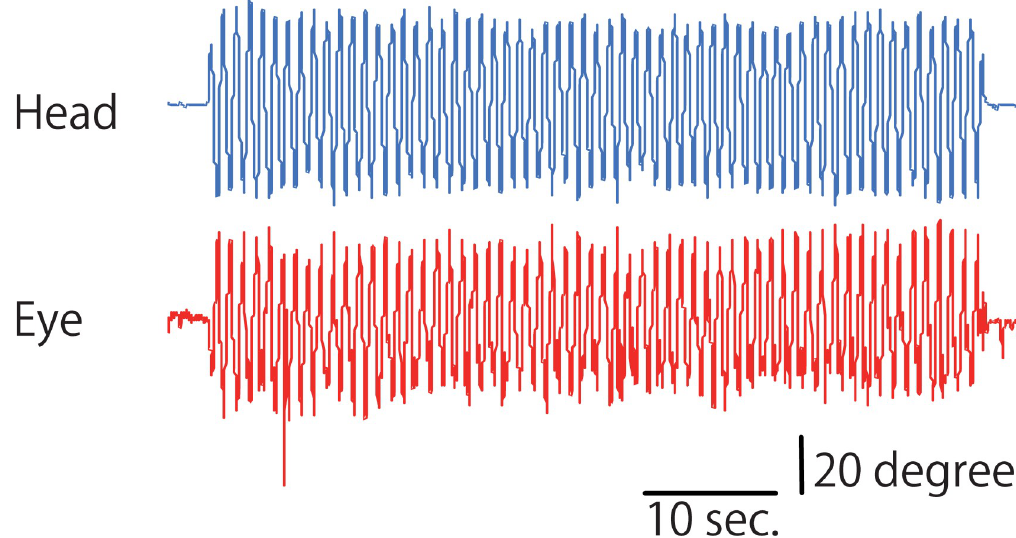
Fig 3. Specimen waveform of the gyroscope and EOG from raw data. The blue and red lines indicate the specimen waveform of the gyroscope (Gyro_Z) and EOG (EOG_H) voltage in the horizontal plane created from raw data extracted from the JINS MEME system during the